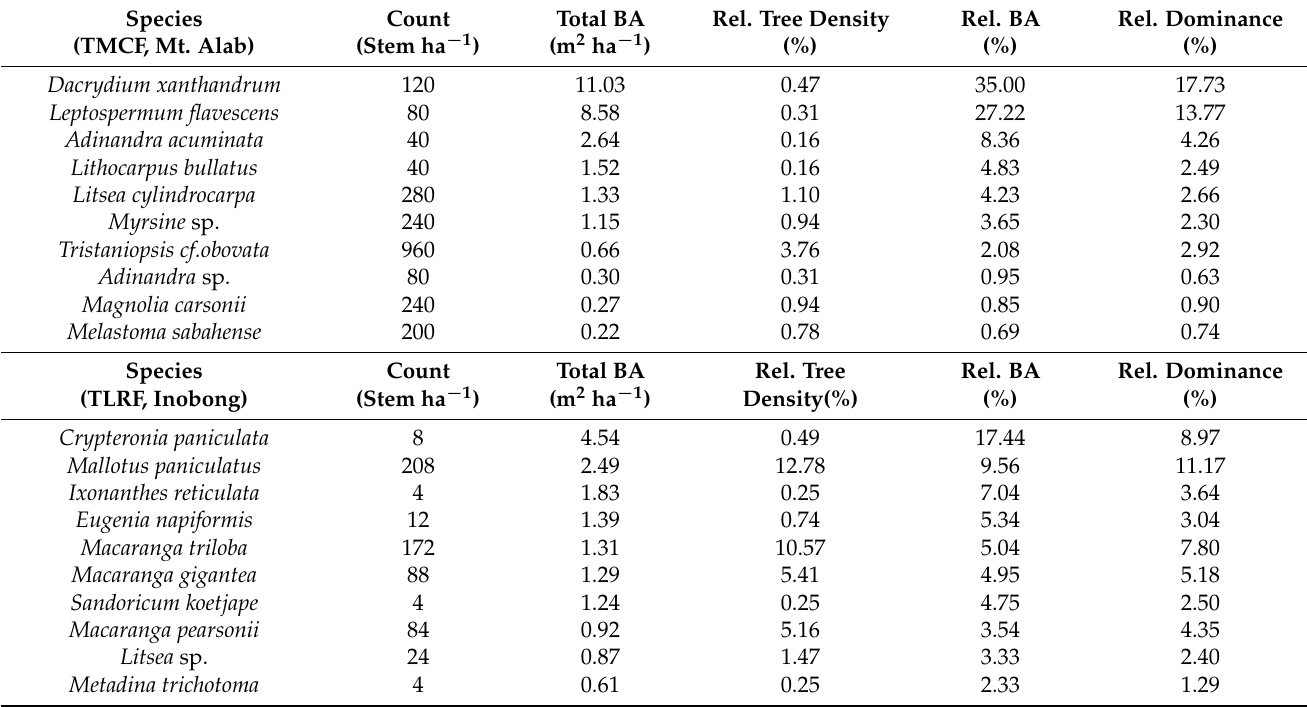
Table 2. Major species in the TMCF (Mount Alab) and the TLRF